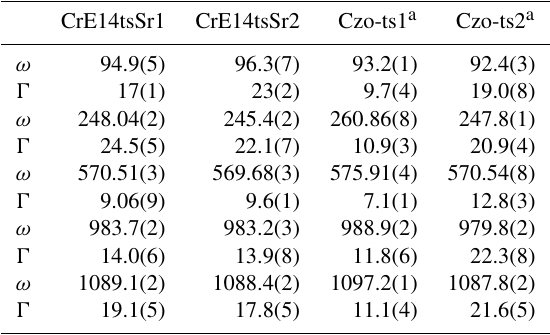
Table 6. The peak position, ω (cm − 1 ) , and FWHM, (cid:48) (cm − 1 ) , of the selected Raman peaks for Sr + Cr-bearing epidote and reference materials.